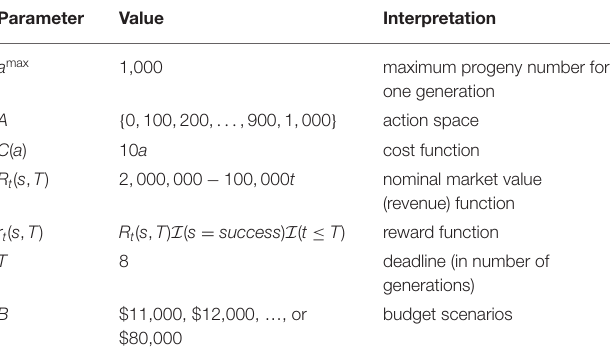
TABLE 1 | Parameters.